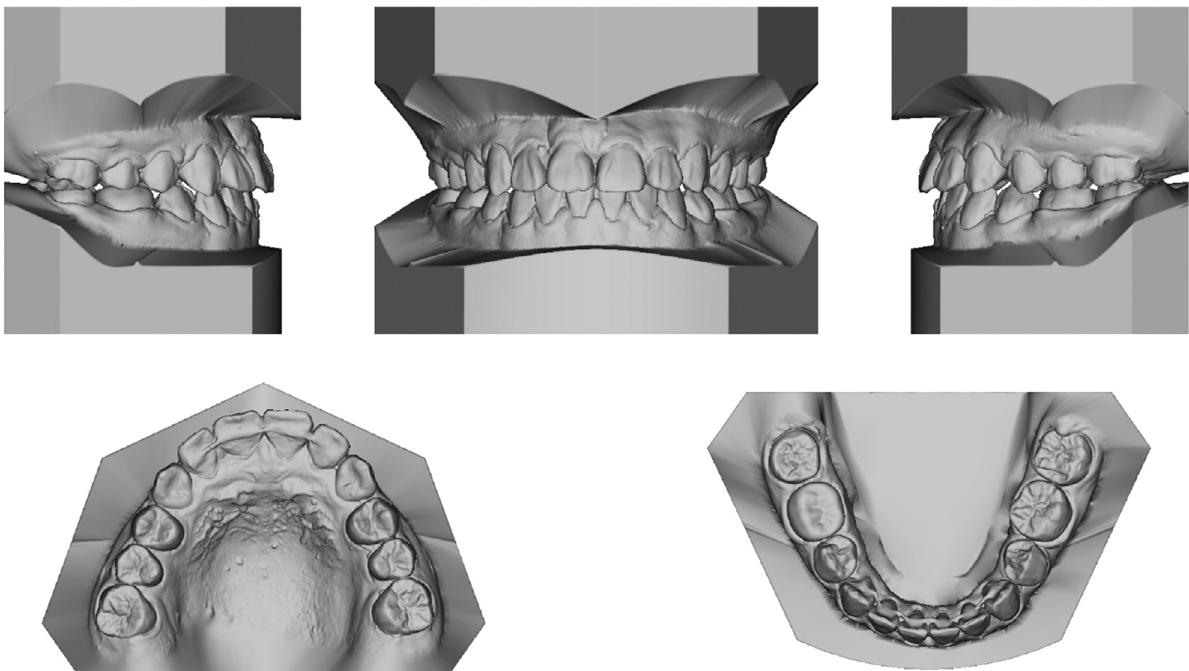
Figure 10. Debond